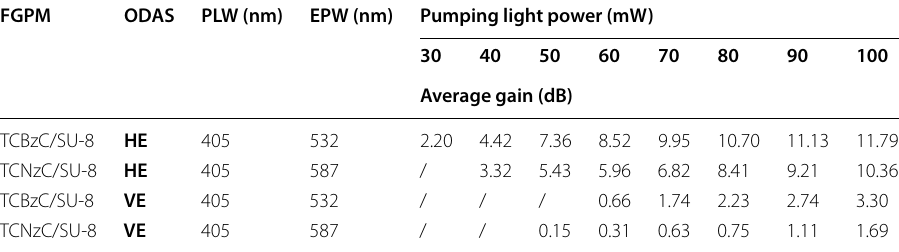
Table 1 The horizontal and vertical average gains based on the active polymers for the 3D integrated on-chip optical